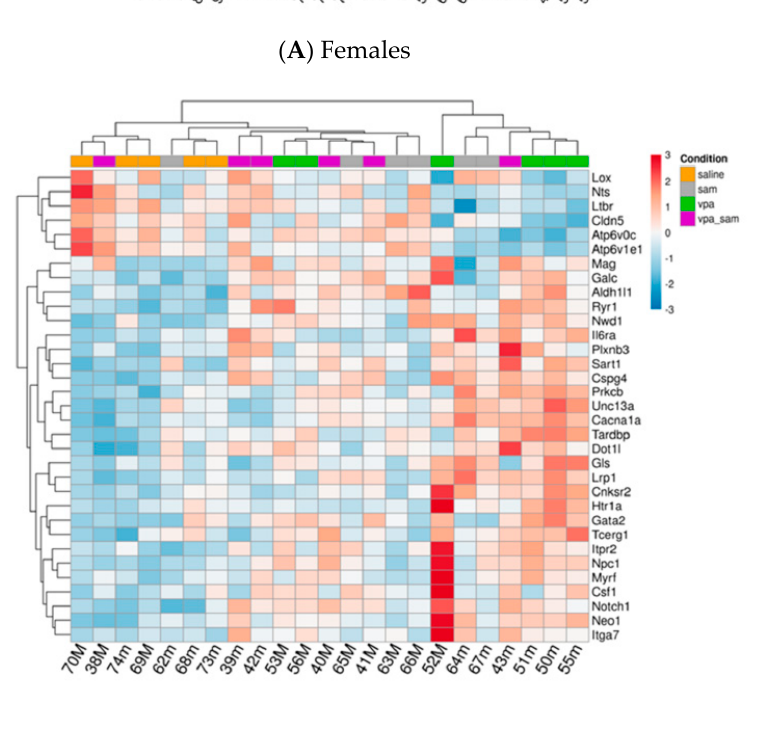
Figure 1. Effect of VPA and SAM administration on the gene expression in the prefrontal cortex. Heat map of the genes significantly changed by VPA in the different groups: A . females, B . males. Each heat map consists of two NanoString panels (12 samples).